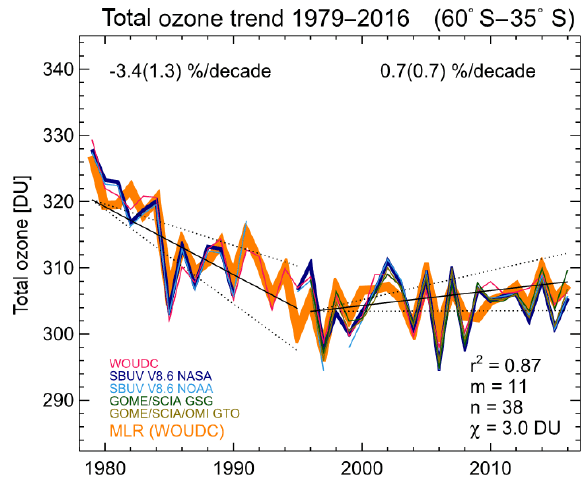
Figure 2. NH annual mean total ozone time series of five bias- corrected merged datasets in the 35–60 ◦ N latitude band (NH ex- tratropics). The thick orange line is the result from applying MLR (Eq. 1) to the NOAA time series. In addition to the standard MLR, AO and BDC-N terms are included (see Eq. 4). n is the number of data (years) used in the MLR and m the number of parameters fit- ted. The square of the correlation between observations and MLR is given by r 2 . χ 2 is the sum square of the time series minus MLR divided by the degrees of freedom ( n − m ). The solid lines indicate the linear trends before and after the ODS peak, respectively. The dotted lines show the 2 σ uncertainty of the MLR trend estimates. Trend numbers are indicated for the pre- and post-ODS peak peri- ods in the top part of the plot. Numbers in parentheses are the 2 σ trend uncertainty.